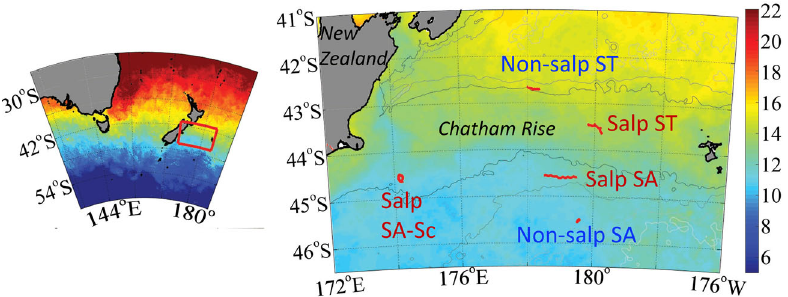
Fig. 1 | Study area. Lagrangian sampling (tracks shown as red lines/dots). Water mass types: Subantarctic Southland Current (SA-Sc), Subantarctic (SA), and Sub- tropical(ST).Thelocationofthebathymetricfeatureislabeled “ ChathamRise ”